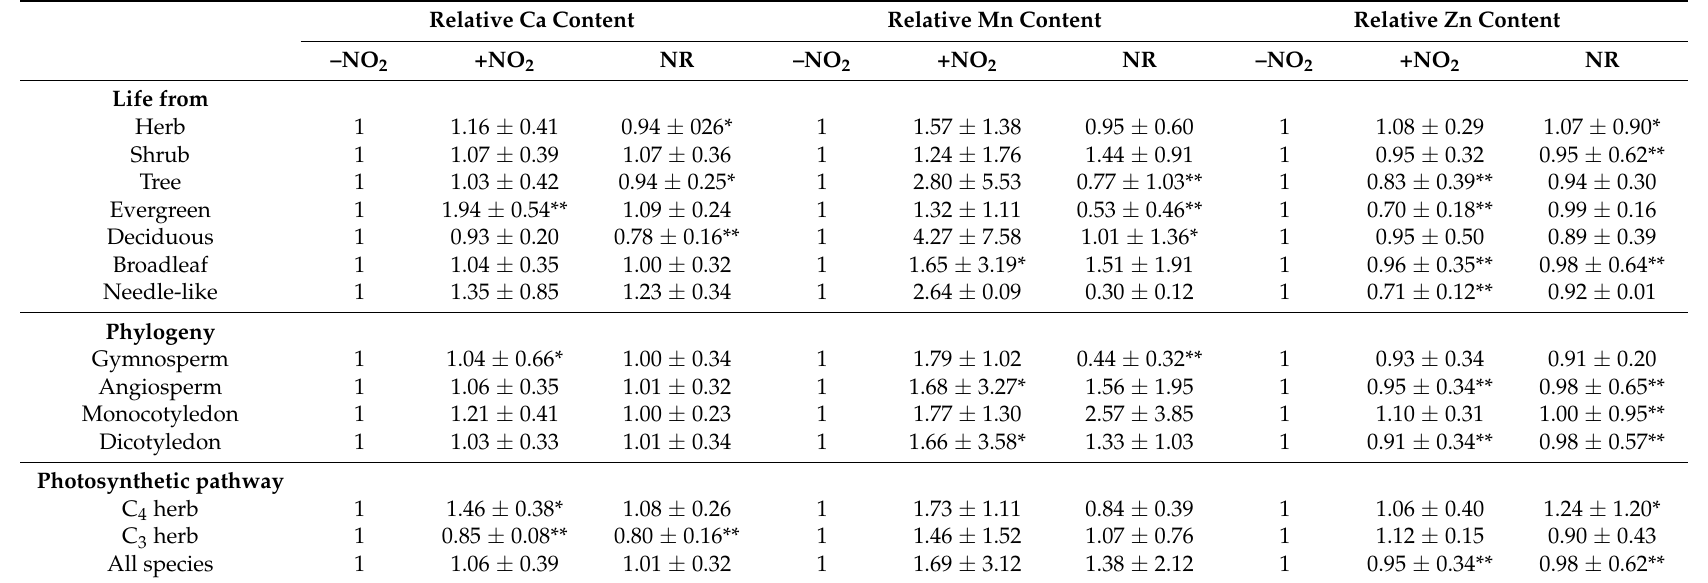
Table 5. Relative Ca, Mn, and Zn contents (folds) in different plant functional groups treated without nitrogen dioxide (NO 2 ) (–NO 2 ), with 72 h NO 2 stress (+NO 2 ) or after 30 d of natural recovery